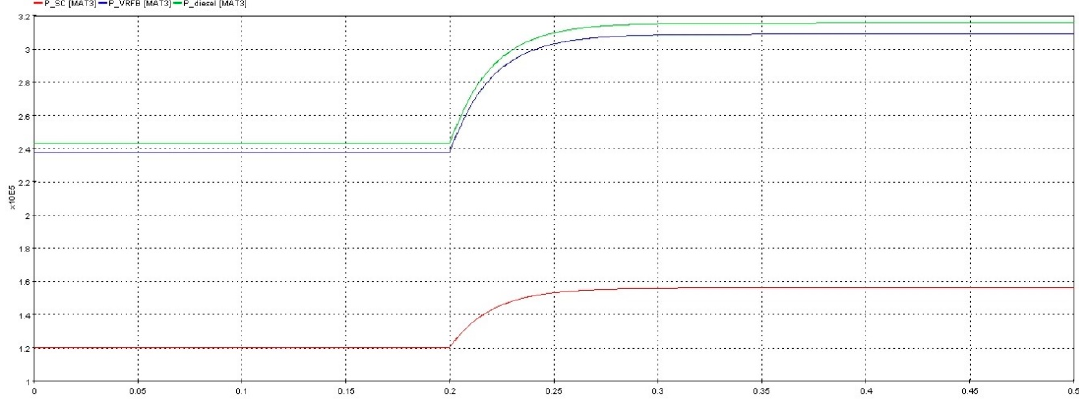
Figure 18. Power regulation curves using the self-learning fuzzy sliding mode droop control.